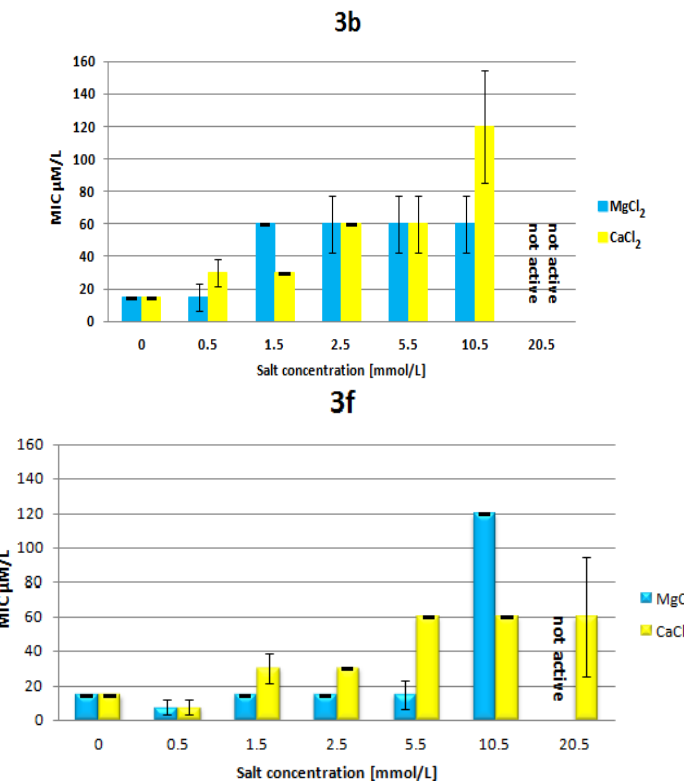
Figure 3. The effect of Ca 2+ or Mg 2+ cations on the minimum inhibitory concentration (MIC) of 3b and 3f against E. coli ATCC 25922 (black bars represent mean